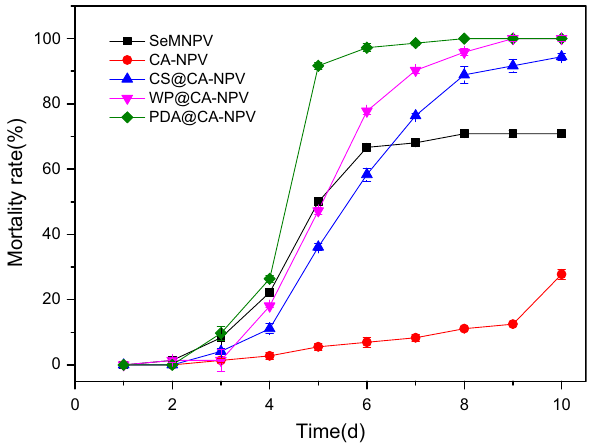
Figure 8. Mortality of SeMNPV and microcapsule formulations following UVB treatment for 2 h, in 2nd instar larvae. The powders of SeMNPV OBs, CA-NPV, WP@CA-NPV, CS@CA-NPV and PDA@CA-NPV were evenly and thinly spread on weighing paper and exposed for 2 h to UVB output at a distance of 31 cm. The irradiated samples were added to the surface of food, and the 6-day-old second-instar larvae were placed into 24-well plates, one hole and one strip, and each sample was performed in triplicate. A small number of deaths occurred in each treatment on the third day after exposure, with mortality rates of 8.3% and 9.7% in the SeMNPV and PDA@CA-NPV treated groups, respectively. On day 5, a large number of deaths occurred, with 50% mortality being observed in the SeMNPV infected group. Also on day 5, the mortality of PDA@CA-NPV treated insects was 91.7%. Over time, on the 8th day, PDA@CA-NPV produced 100% mortality. The mortality of WP@ CA-NPV and CS@CA-NPV groups was 95.8% and 88.9%, respectively. The mortality of SeMNPV infected larvae reached to 70.8%.